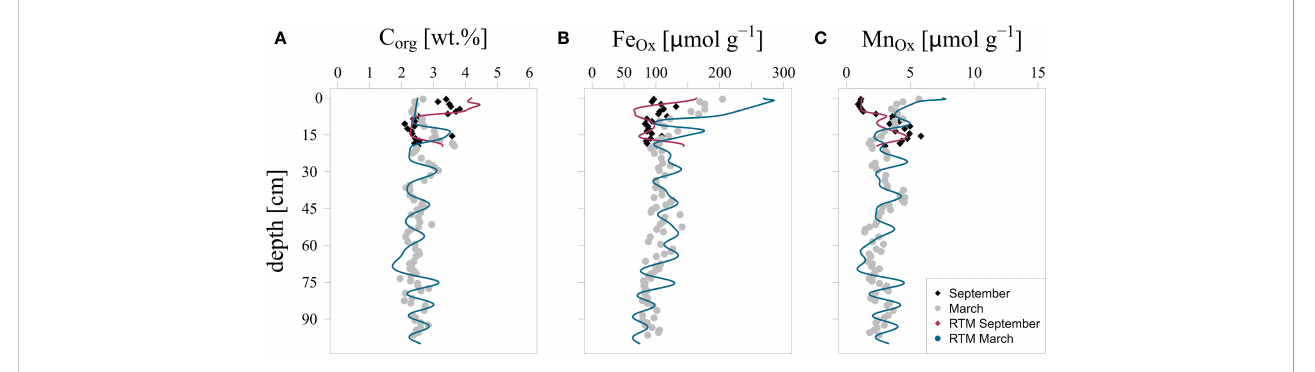
FIGURE 3 Measured and modeled depth pro fi les of (A) : organic carbon (C org ), (B) : Fe oxides and (C) : Mn oxides in the sediment in March and September 2020.